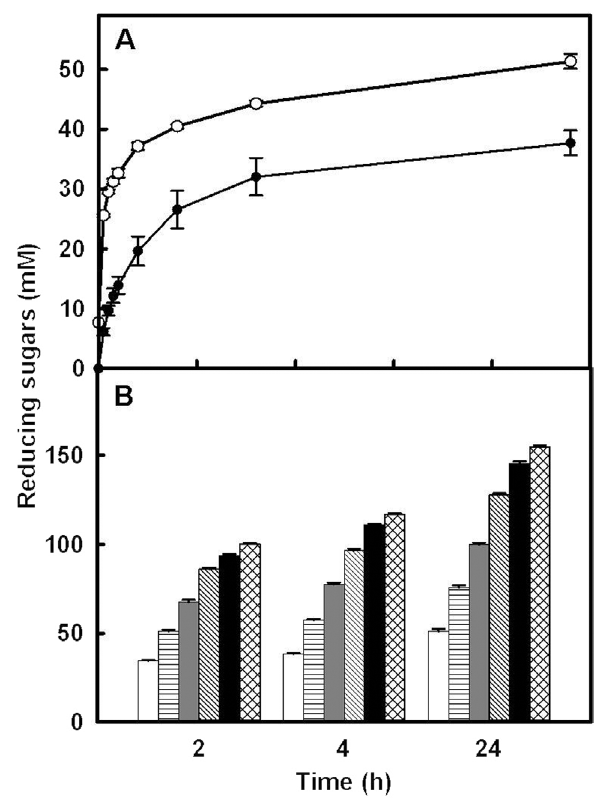
Figure 6 (A) Time course profile of reducing sugars concentration resulting from the enzymatic hydrolysis of natural (●) and regener- ated (○) corn cob by the combined action of cellulase (Celluclast 1.5L, 4.6 mg/ml of reaction medium) and cellobiase (Novozyme 188, 1.4 mg/ml of reaction medium), using a 2% (w/v) substrate concen- tration in citrate buffer pH 4.8 at 50 ° C. (B) Effect of the regenerated corn cob concentration (20 mg/ml, white; 30 mg/ml,